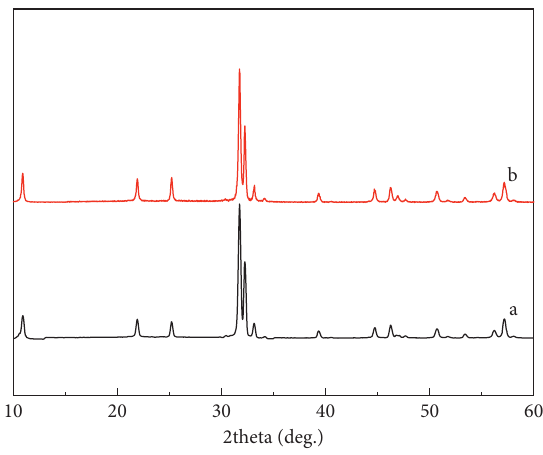
Figure 13: XRD spectra of HBSMs (a) and HBSMs after six cycles (b) for the photocatalytic degradation of the